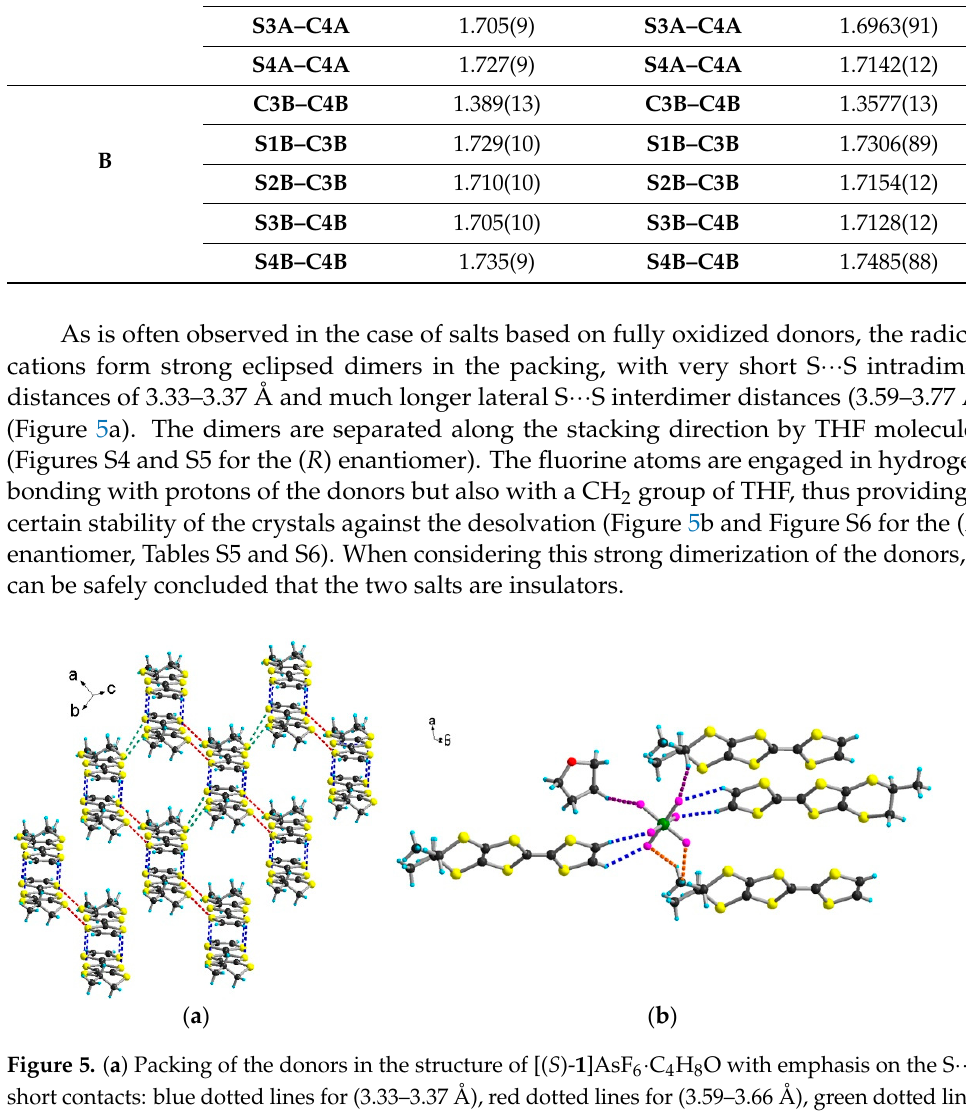
Table 2. Selected C = C and C–S internal bond distances for [( S )- 1 ] 2 AsF 6 and [( S )- 1 ] 2 AsF 6 .